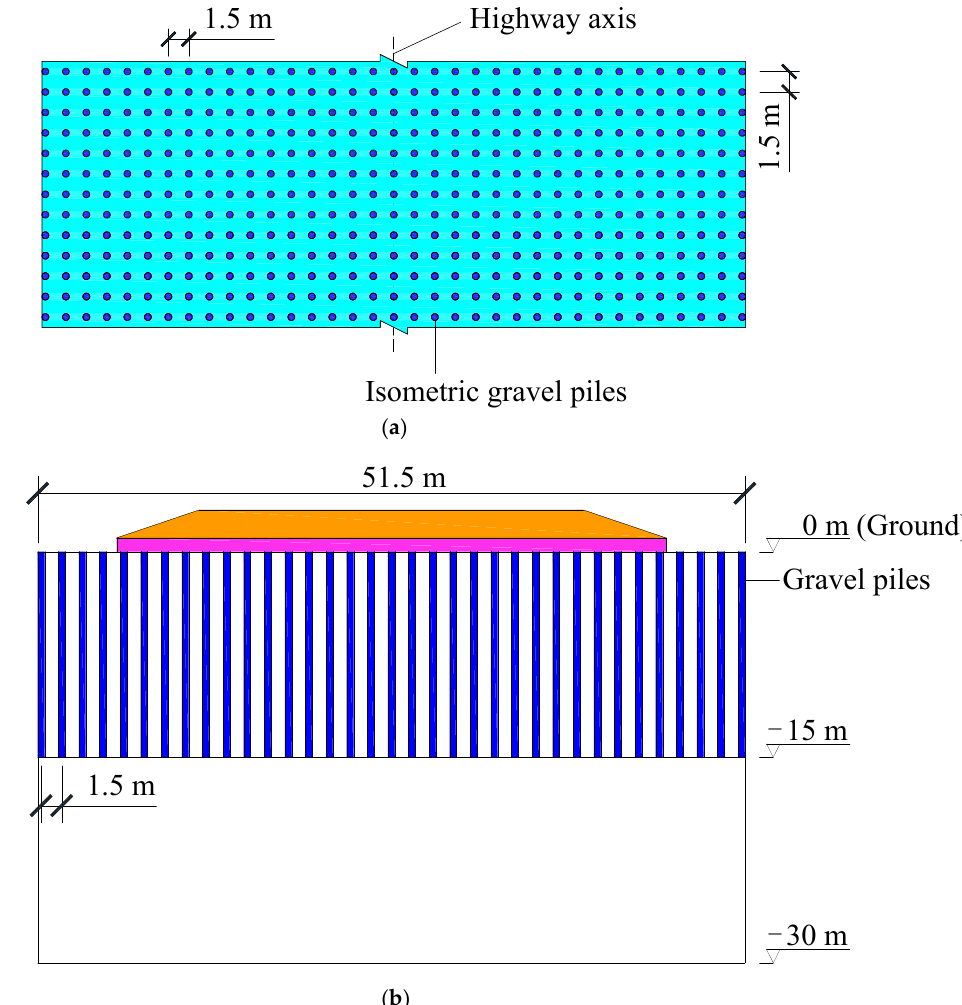
Figure 4. Layouts of the isometric gravel piles scheme. ( a ) Planar layout. ( b ) Cross-sectional layout.